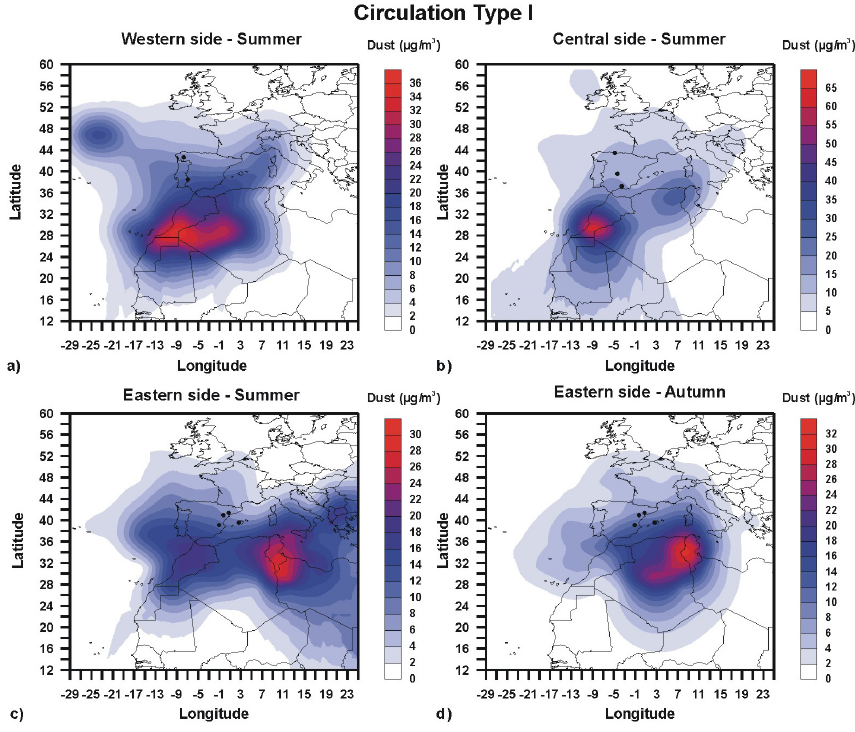
Figure 10. RCFs for African dust contributions (µgm − 3 ) during ADO generated by circulation type I over the western, central and eastern sides of the area of study in summer and autumn.